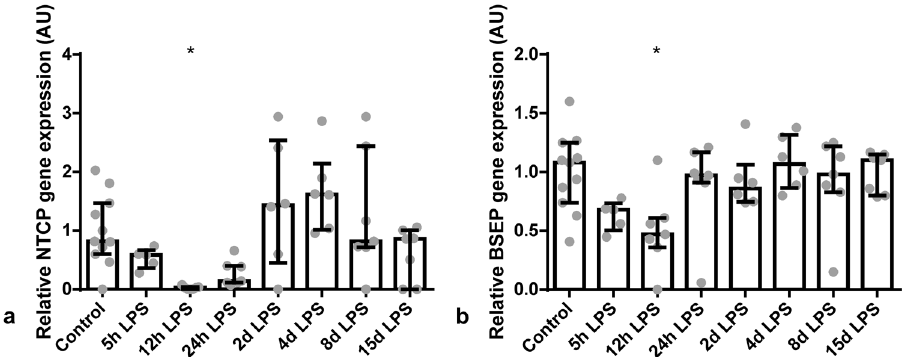
Figure 4. Relative hepatic NTCP and BSEP gene expression in AU. Data are presented as median with IQR. NTCP ( a ) and BSEP ( b ) were decreased 12 hours after IA LPS administration. * P < 0.05 compared to control.